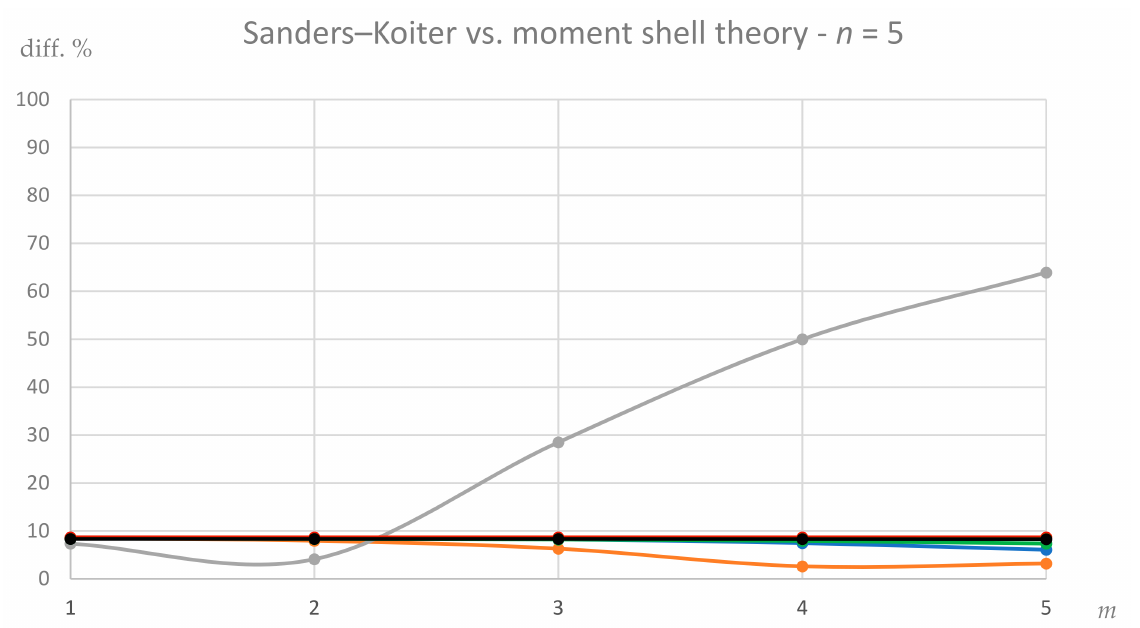
Figure 10. Simply supported DWCNT of Table 1 with different values of aspect ratio L / R 2 and thickness ratio R 2 / h . Shell-like modes ( n = 5). Comparisons between extended Sanders–Koiter and simplified moment shell theories, where L / R 2 = 10, R 2 / h =